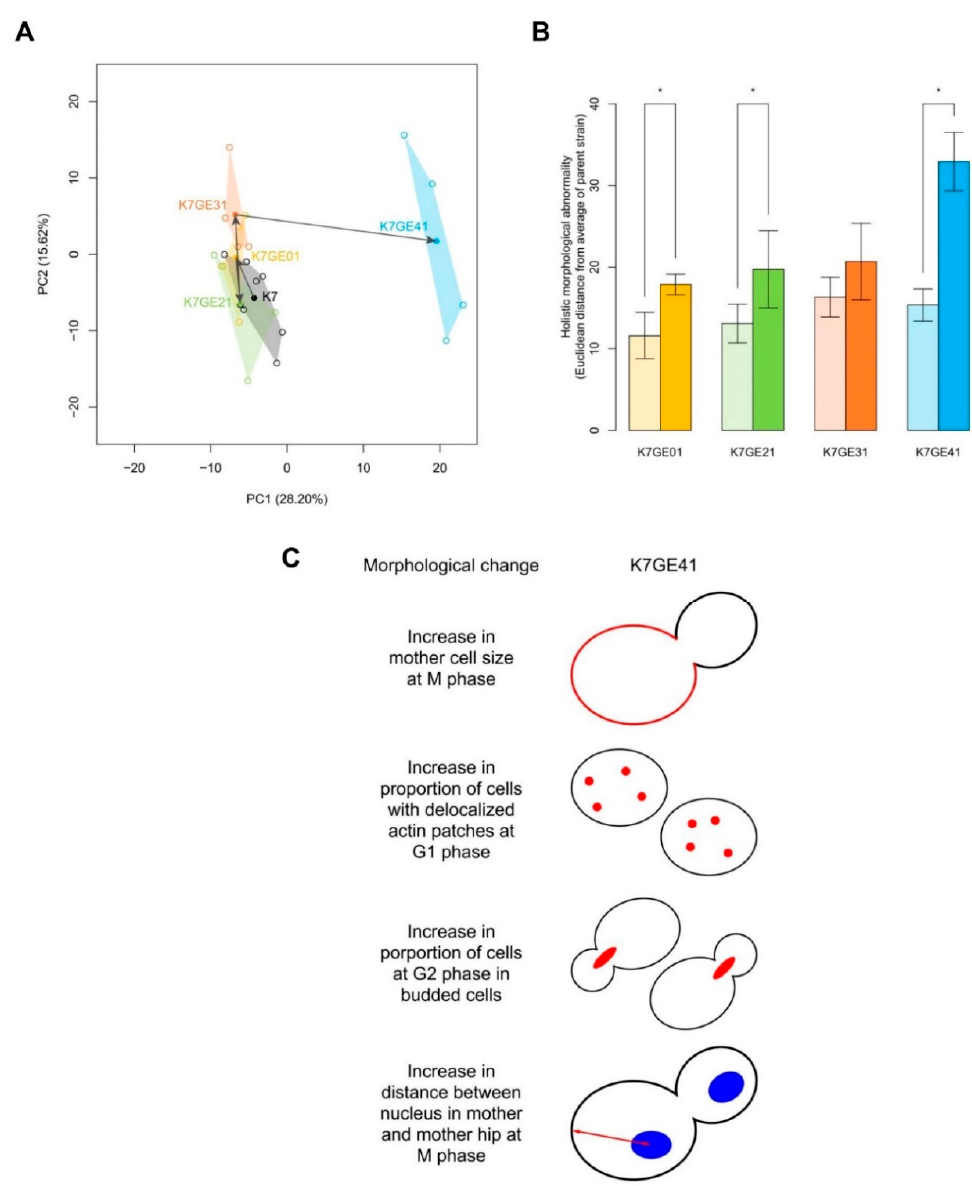
Figure 7. Morphological changes during serial breeding. ( A ) Distribution of sake yeast isolates in the orthogonal morpho- logical space. Principal component analysis was performed on 501 morphological traits of four genome editing strains. K7GE01, K7GE21, K7GE31, and K7GE41 ( n = 4 each, open circles) and the standard K7 strain ( n = 7, open black circles). The colors of the strain names and regions are the same as in Figure 1. The first two PCs (PC1 x -axis, PC2 y -axis) captured 43.82% of the variance, as shown in parentheses. The center of each strain was calculated as the average of the PC score and is shown as a solid circle. Arrows indicate the direction of breeding. ( B ) Euclidean distances from their parental strain. The holistic morphological abnormality was calculated as the Euclidean distance of each replicate from the center of the parental strain in the orthogonal morphological space of the 11 PCs capturing 90% of the variance of the 501 traits. Light and vivid colors indicate the parent strains and genome-editing strains K7GE01, K7GE21, K7GE31, and K7GE41, respectively. The error bar indicates the standard deviation. An asterisk indicates a significant difference at p < 0.05 after the Bonferroni correction (likelihood ratio test of one-way ANOVA with a gamma distribution). ( C ) Schematic representation of the morphological features of the genome-edited sake yeast strains. One-way ANOVA of the generalized linear model was applied to 501 morphological traits of five sake yeast strains, and 31 traits were detected at p < 0.05 after the Bonferroni correction. Of the 31 traits, 23 in at least one genome editing strain differed significantly from K7 at p < 0.05 by the Wald test. K7GE01, K7GE21, K7GE31, and K7GE41 differed significantly from K7 in 4, 3, 9, and 17 traits, respectively. The 23 detected morphological traits were summarized by successive PCA with 114 replicates of BY4743 and are